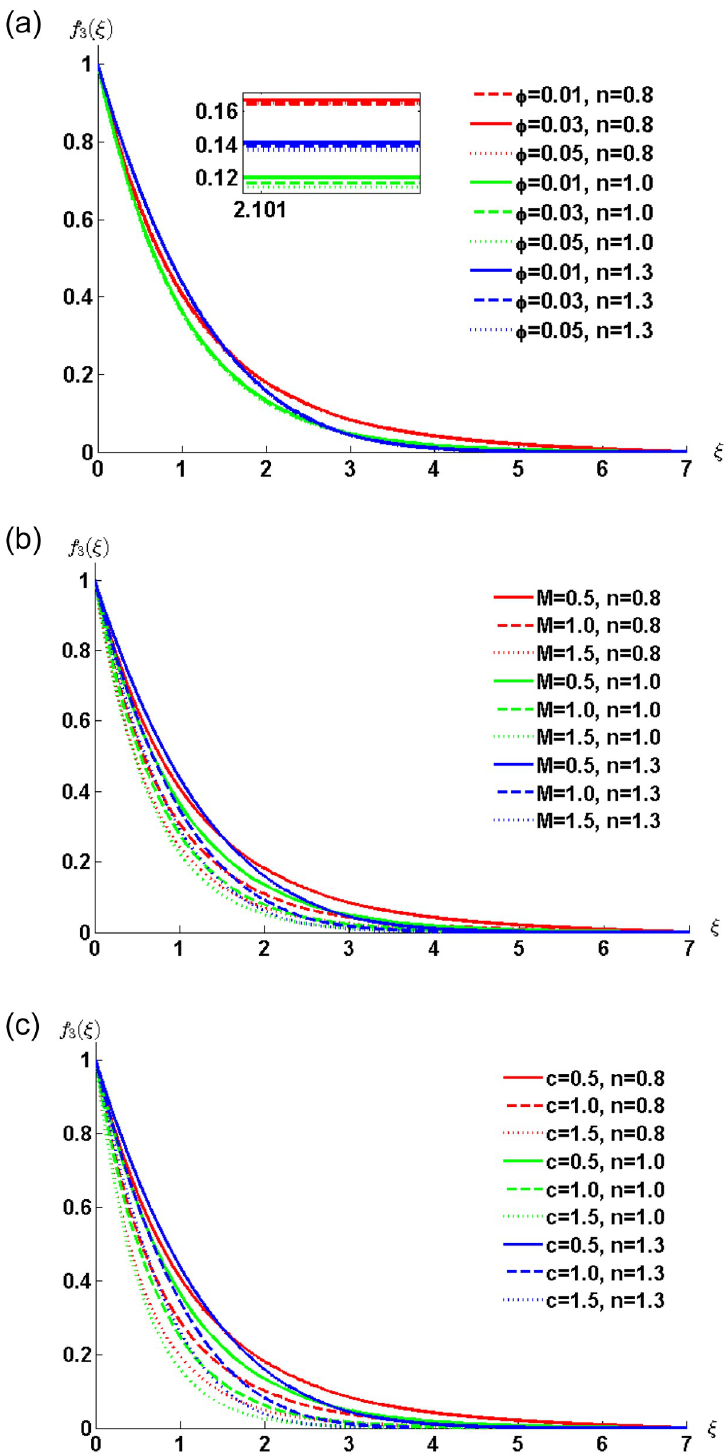
Fig 9. Velocity profile for various values of φ , M and c when ρ s = 8933, ρ f = 997.1, σ s = 5.5 × 10 − 6 and σ f = 5.96 × 10 7 are fixed.